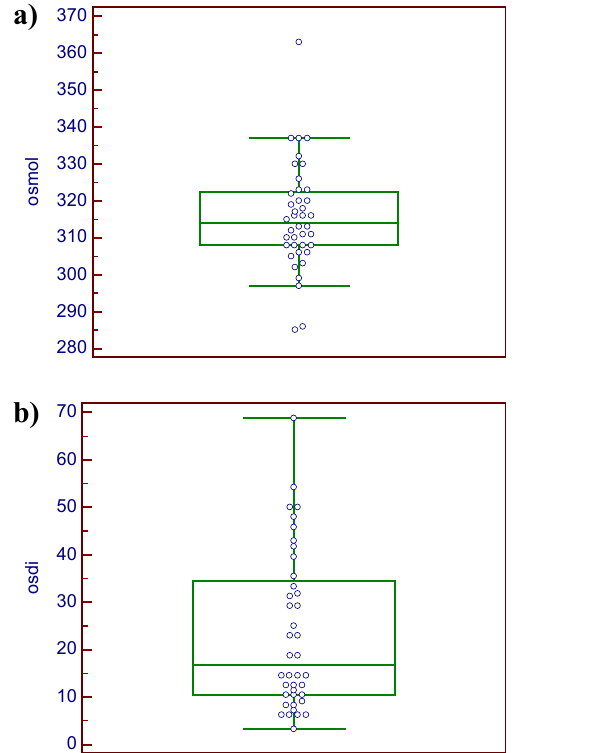
Figure 1 . Box and whisker plots of medians and interquartile ranges are shown for tear osmolarity (Figure 1a) and OSDI score (Figure 1b). Circles indicate each measurement/score. See text for an explanation of the plots.